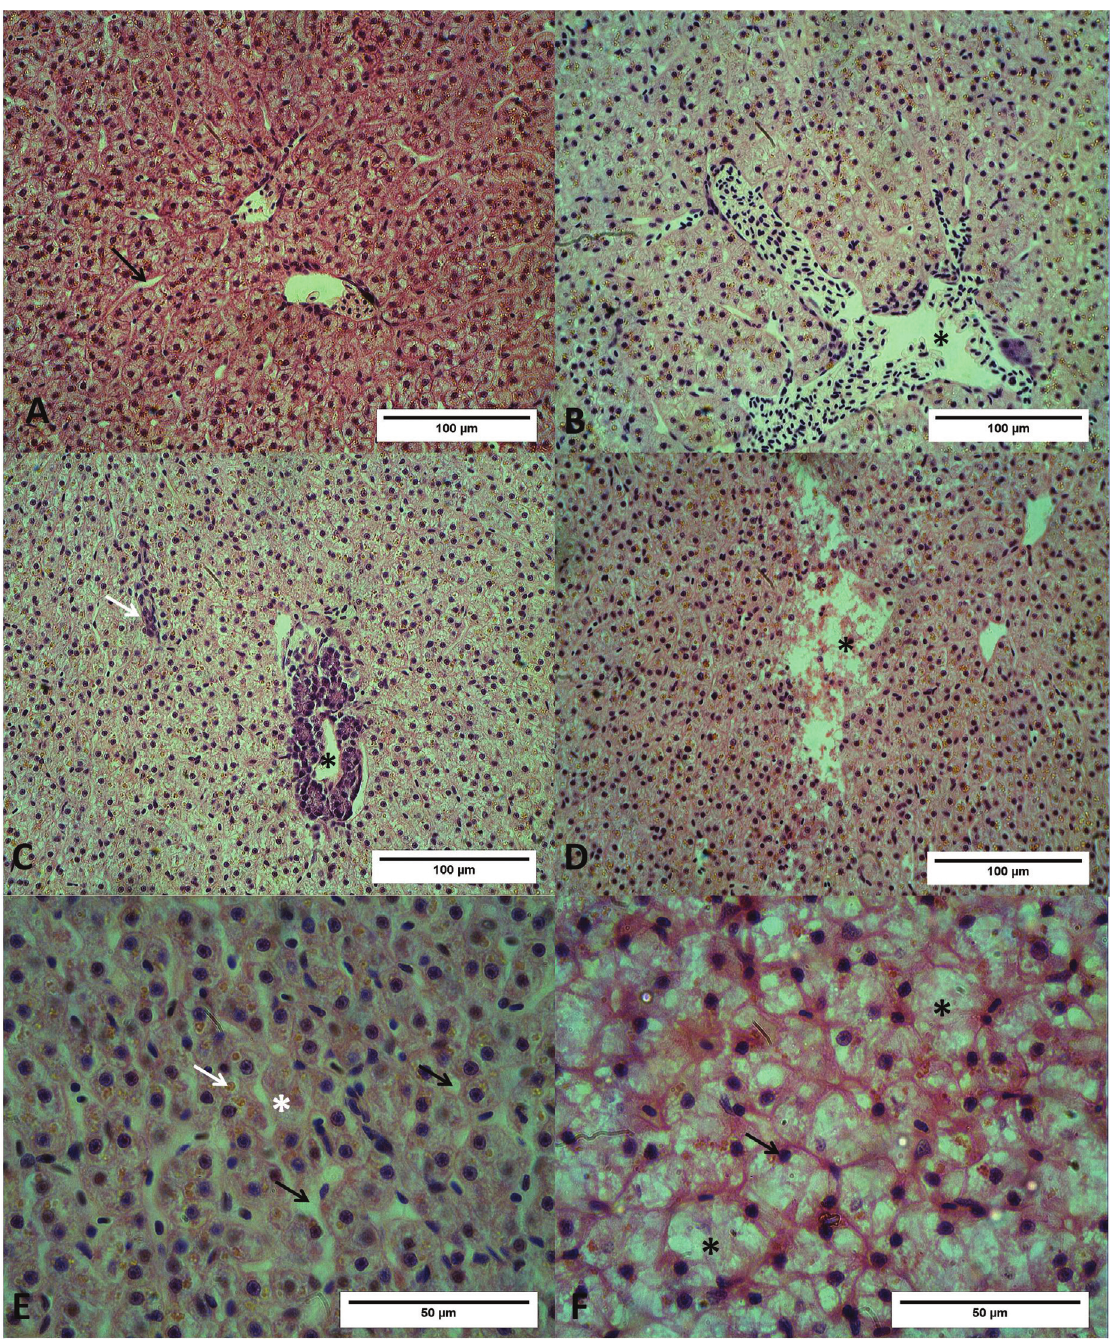
Figure 1 - C. macropomum liver exposed to corn oil (control group) or doses of B[a]P. (A) Normal liver, hepatocytes are organized in one or two layers surrounded by sinusoids (black arrows). (B) Normal liver parenchyma, highlighting a blood vessel with red blood cells (asterisk). (C) Image of liver ex- posed to 8 (cid:3) mol/kg B[a]P evidencing a hepatopancreas (asterisk) and sinusoid obstruction (white arrow). (D) Image of fish liver exposed to 8 (cid:3) mol/kg B[a]P, showing necrotic area (asterisk). (E) Image of liver exposed to 16 (cid:3) mol/kg B[a]P showing some hepatocytes without nucleus (white asterisk), si- nusoidal dilatation (black arrows) and hemosiderin (white arrow). (F) Image of vacuolated hepatocytes of fish exposed to 32 (cid:3) mol/kg B[a]P; cytoplasm degeneration (black asterisks) and pyknotic nuclei (black arrow) are evident. Slides were stained with hematoxylin and